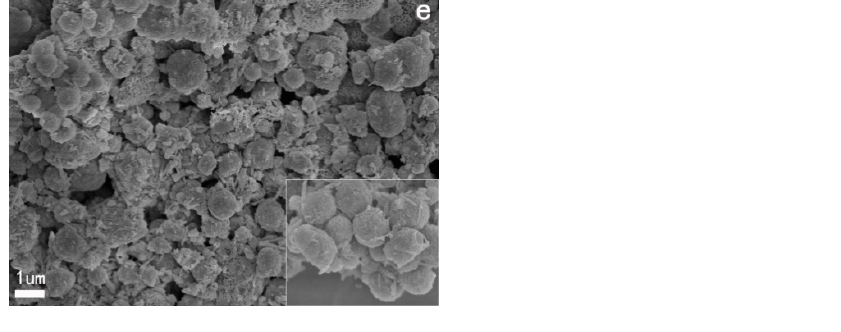
Figure 3. SEM images of ( a ) HNTs; ( b ) TH-HNTs; ( c ) UF; ( d ) UF-H-20%, and ( e ) UF-TH-20%.